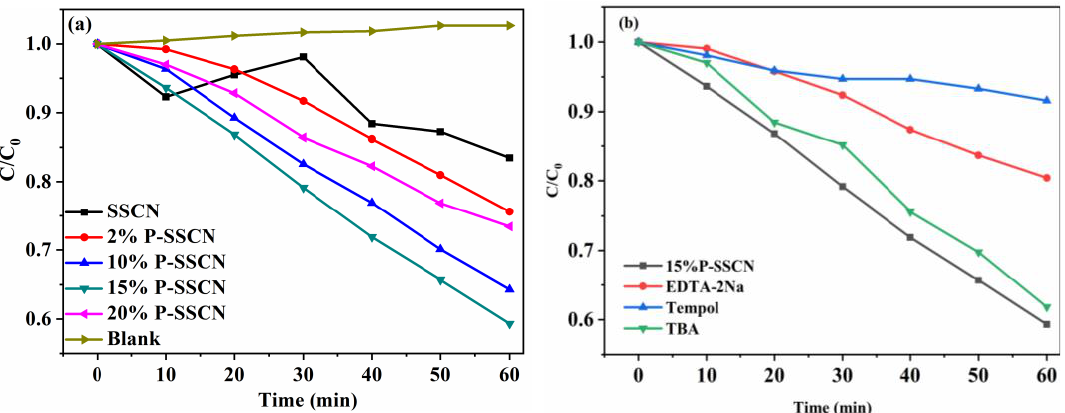
Figure 8. ( a ) Photocatalytic degradation of TC-HCl and ( b ) trapping experiment results of the photodegradation of TC-HCl.